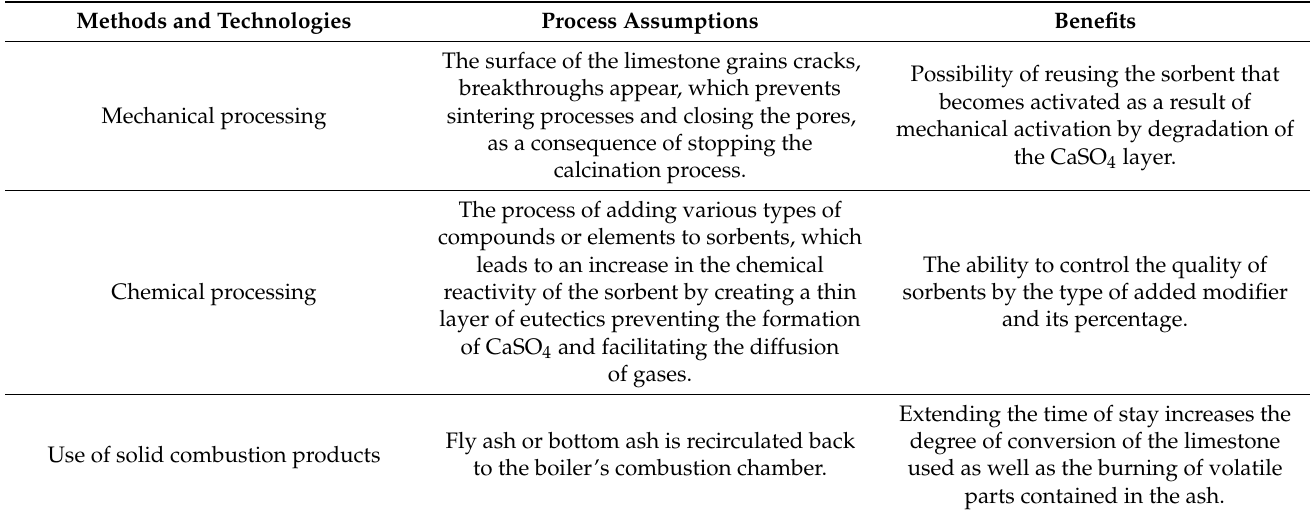
Table 2. Methods of improving the reactivity of calcium sorbents